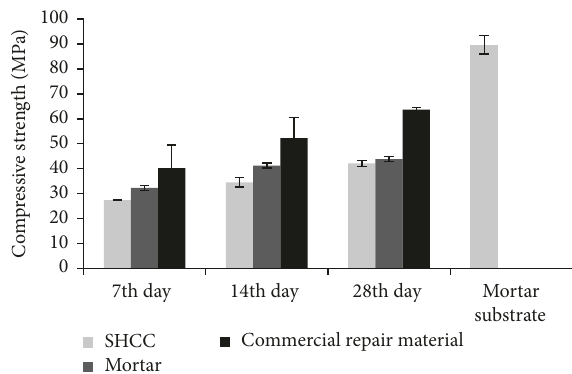
Figure 19: Compressive strength results of the repair materials and mortar substrate used in this study.